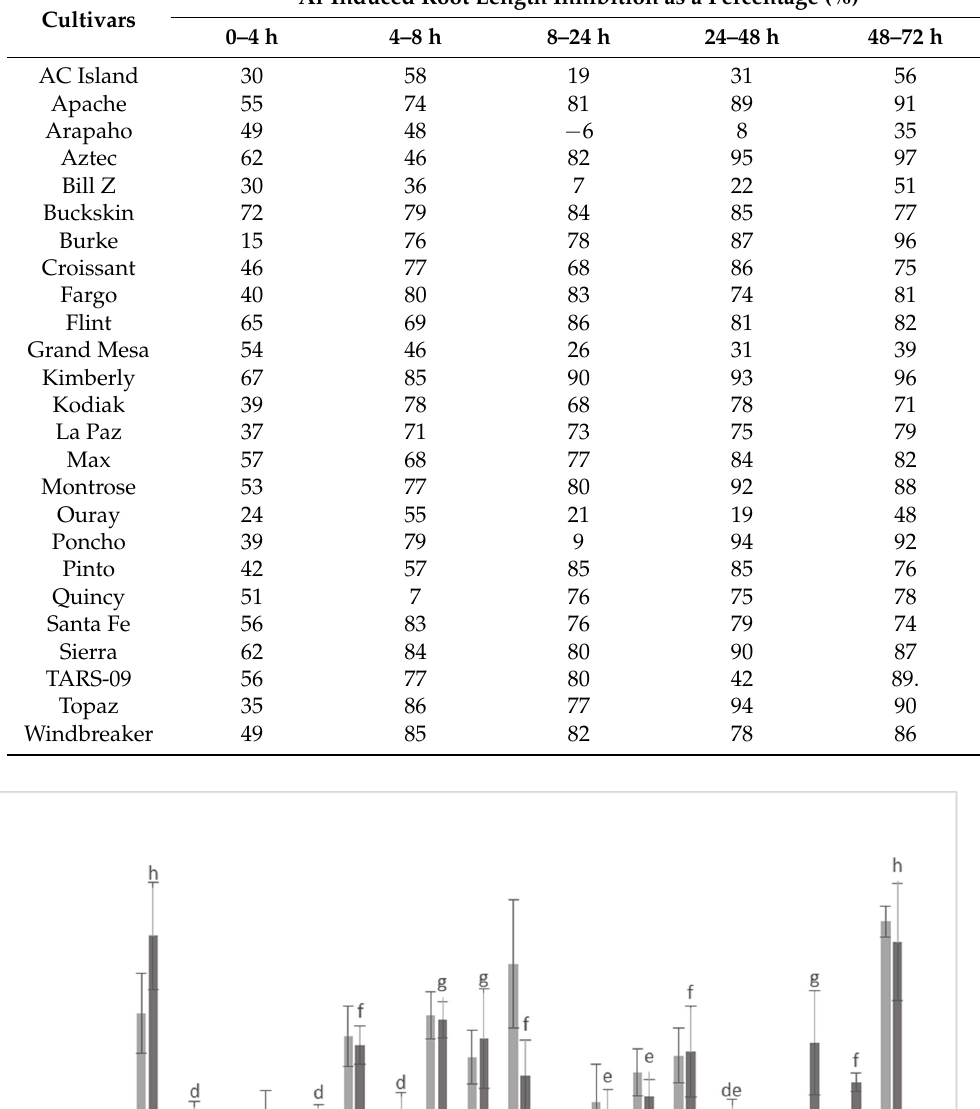
Table 3. The root length inhibition percentage of 25 common bean cultivars 4, 8, 24, 48, and 72 h after AlCl 3 treatment, relative to non-stressed controls.